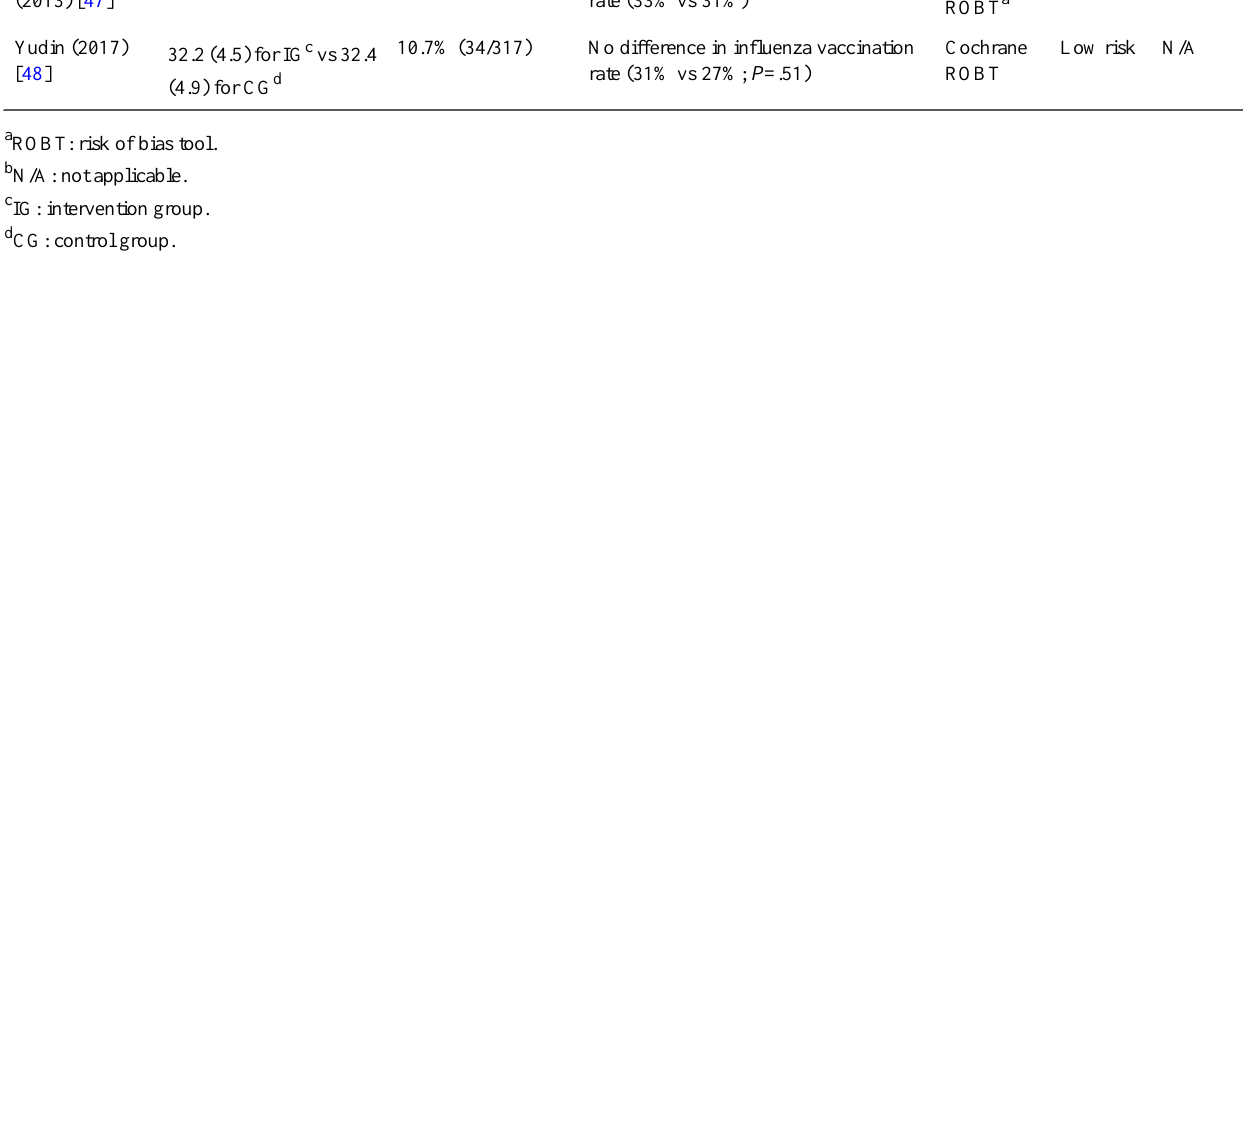
DurationIntervention description and controlExperimental arm vs control